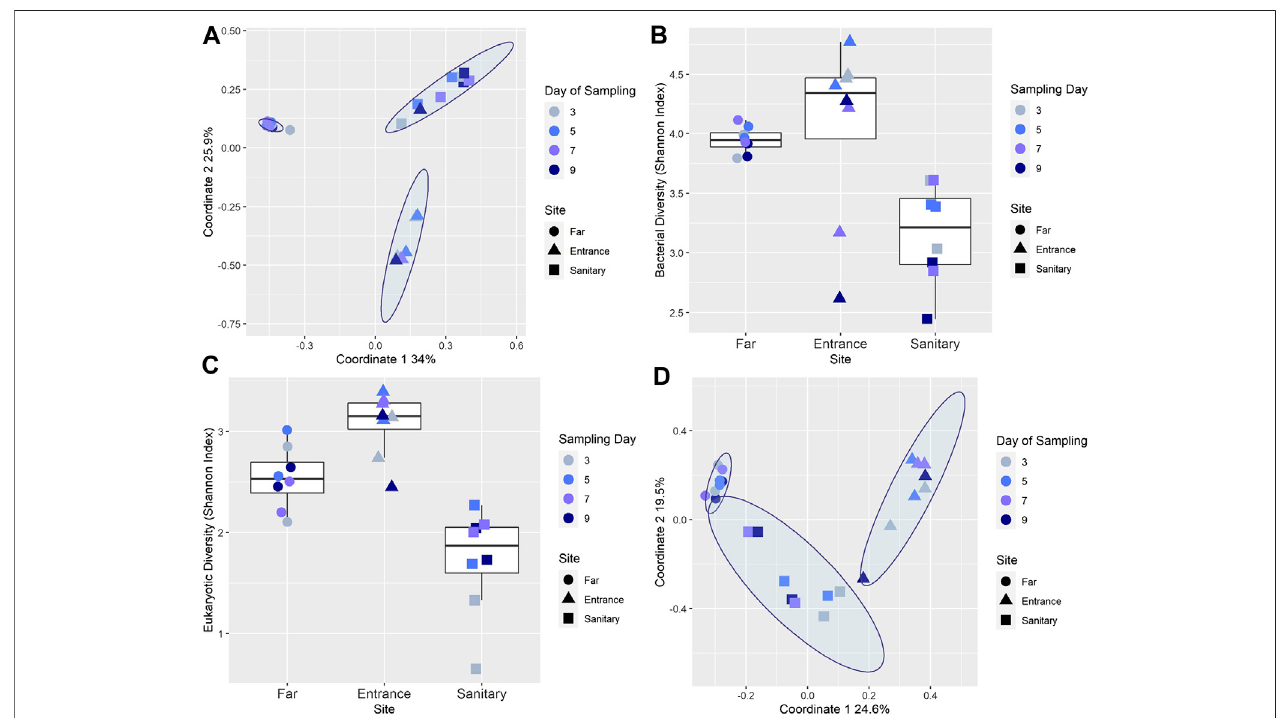
FIGURE 2 | (A) Similarity in microbial composition across different sites and days. PCoA of all soil samples throughout the mission, visualizing the spatial relationships between samples. A strong separation is observed between the three sites, with ANOSIM statistic R (cid:2) 0.8307, Signi fi cance: 0.001. (B) Microbial Shannon diversityindexofsoilsamples.Colorsdenotethesamplingday,andshapedenotestheoriginsite. (C) Similarityineukaryoticcompositionacrossdifferentsitesanddays. PCoA of all soil samples throughout the mission, visualizing the spatial relationships between samples. A separation is observed between the three sites, with ANOSIMstatisticR (cid:2) 0.6,Signi fi cance:0.001. (D)